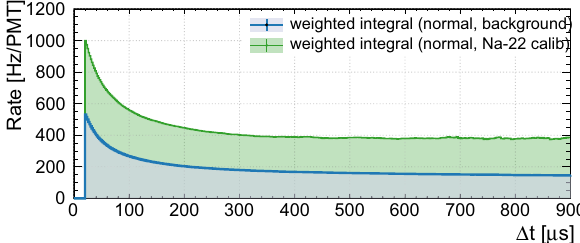
Fig. 4 Thepre-eventlightlevelasafunctionofthe Δ t cut,foranormal physics run (this is the same curve as in Fig. 3) and data taken with a 22 Na gamma calibration source. The level of stray light increases due to the increased total event